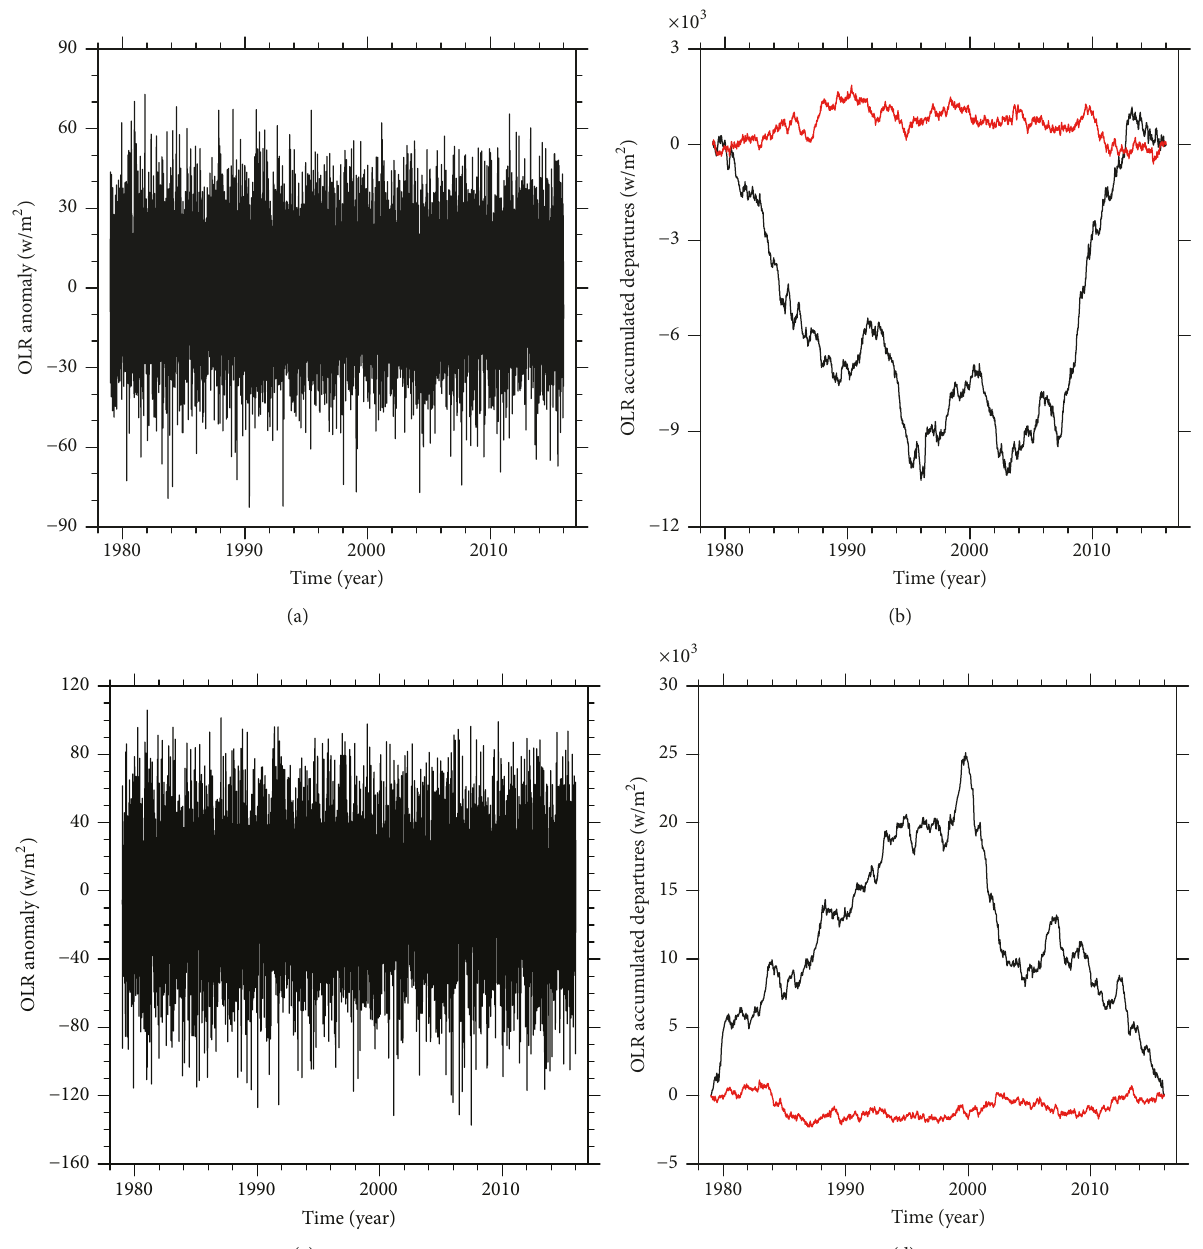
Figure 1: The anomaly and cumulative deviation of OLR in TP (a, b) and IMR (c, d). The black and red line in (b) and (d) represent the original and shuffled time series,